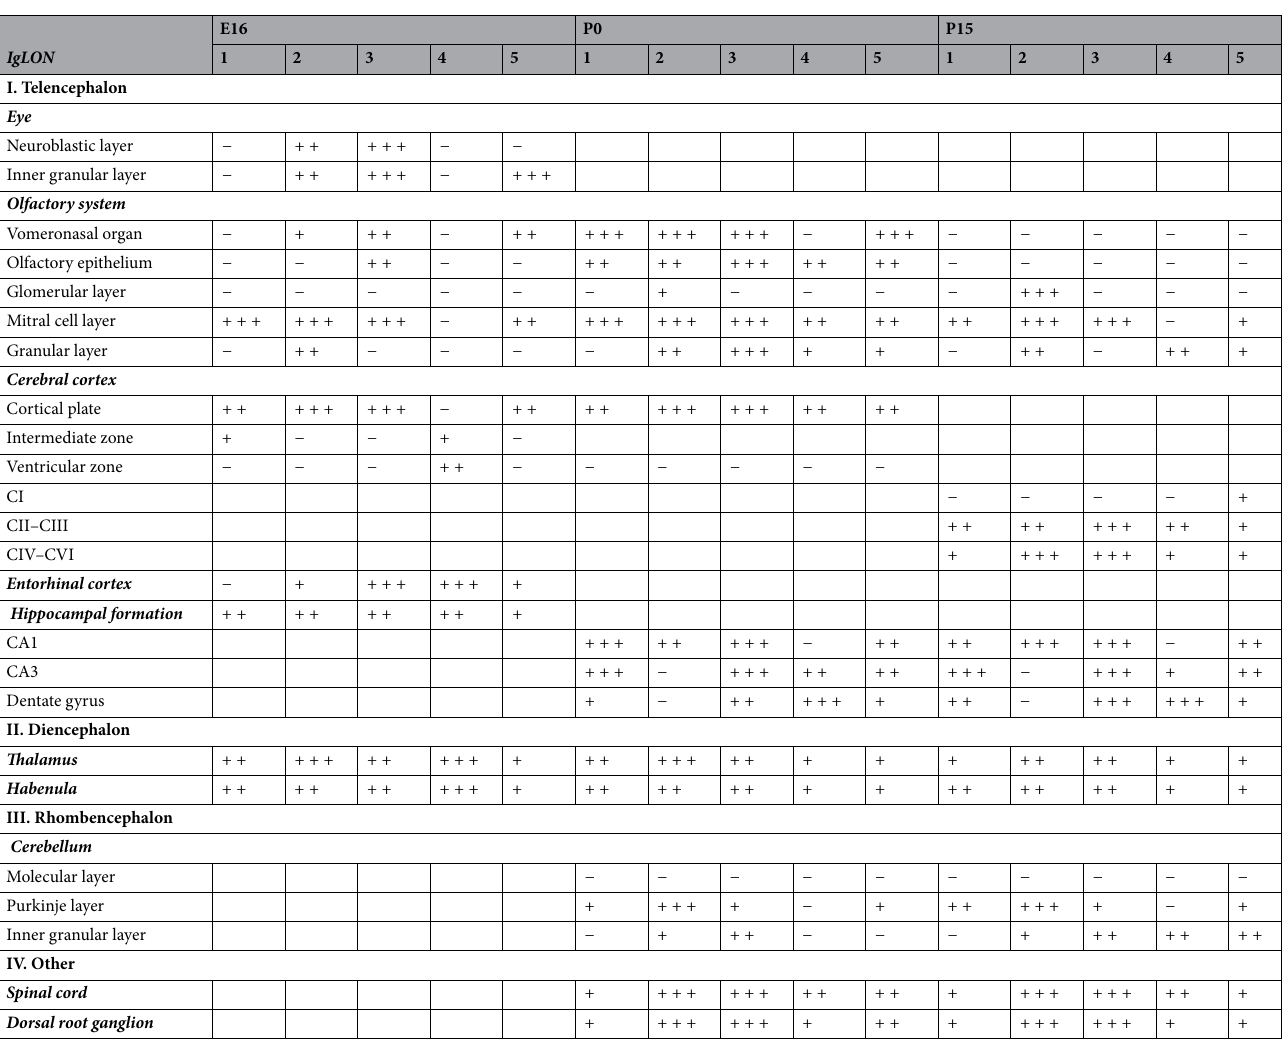
Table 1. Summary of IgLON gene expression in the developing murine nervous system. Relative gene expression: − , not detected; + , low expression; + + , medium expression; + + + , high expression, E, embryonic; P, postnatal